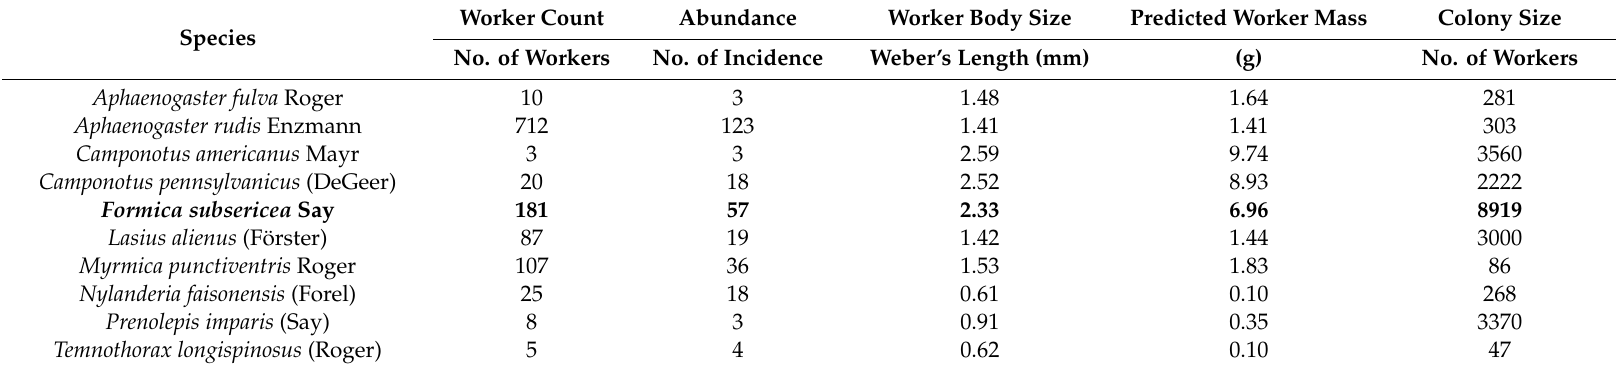
Table 1. Metrics used to estimate behavioral dominance, numerical dominance and ecological dominance. Worker Count Abundance Worker Body Size Predicted Worker Mass Colony Size Species